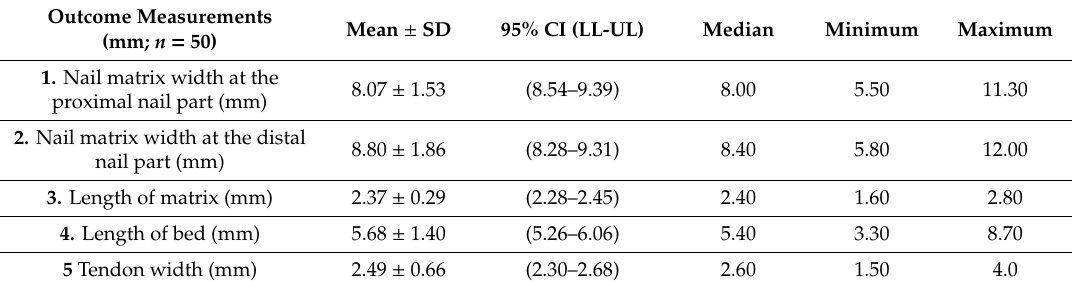
Table 1. Dimensions of the matrix, bed and EDL tendon of the second toes ( n = 50). Outcome Measurements (mm; n =